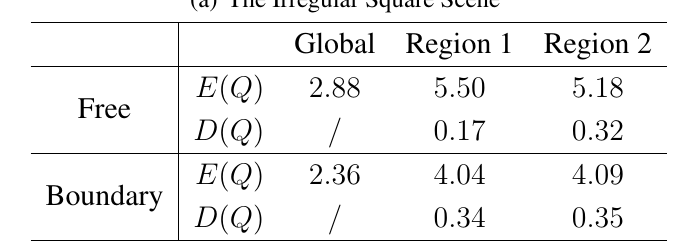
Table 2. Observation quality distribution data of scenes with critical regions. (a) The Irregular Square